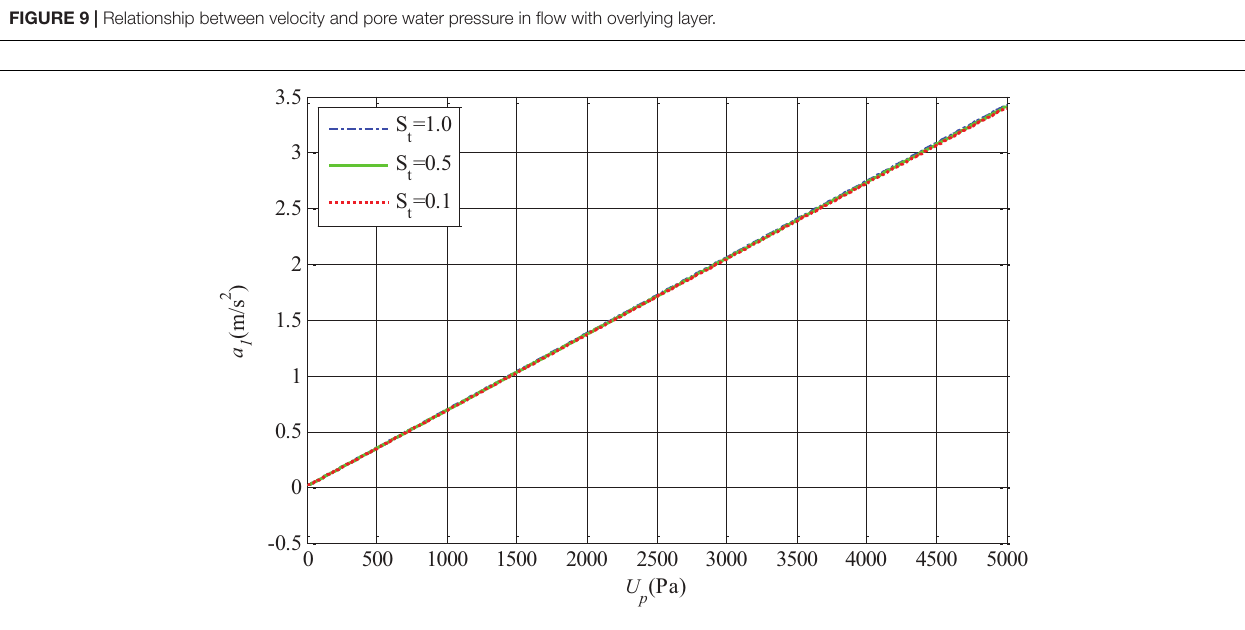
FIGURE 10 | Relationship between acceleration and pore water